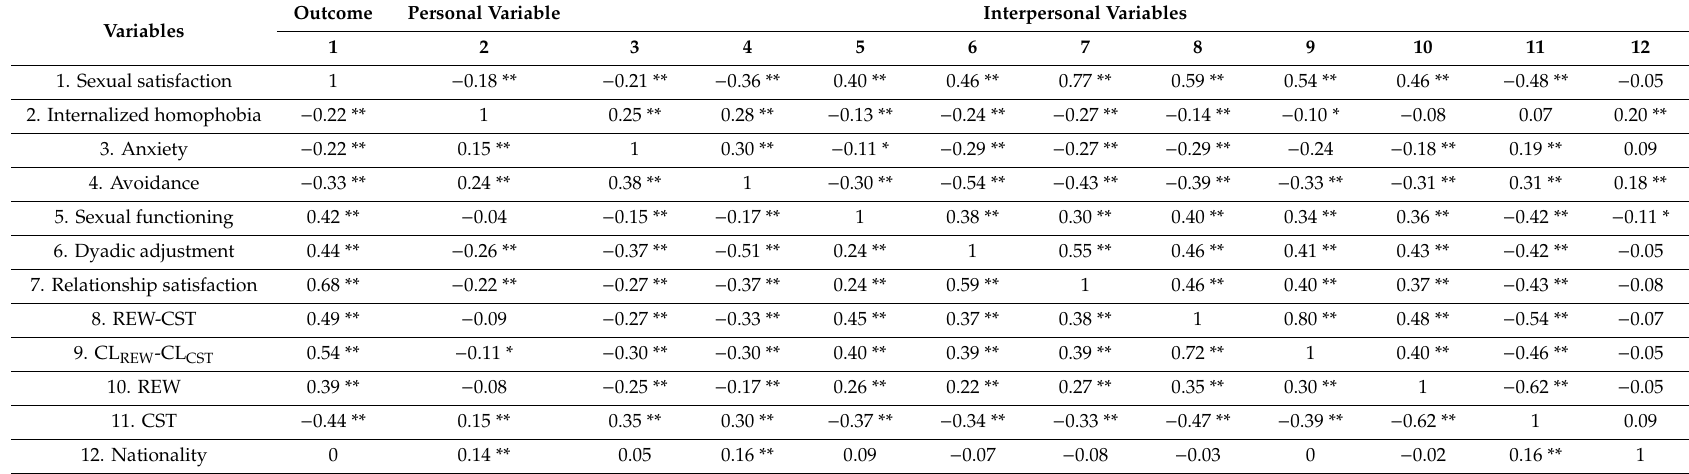
Table 3. Correlations between sexual satisfaction with personal and interpersonal variables and with the nationality variable in men and women with a same-sex partner. Outcome Personal Variable Interpersonal Variables